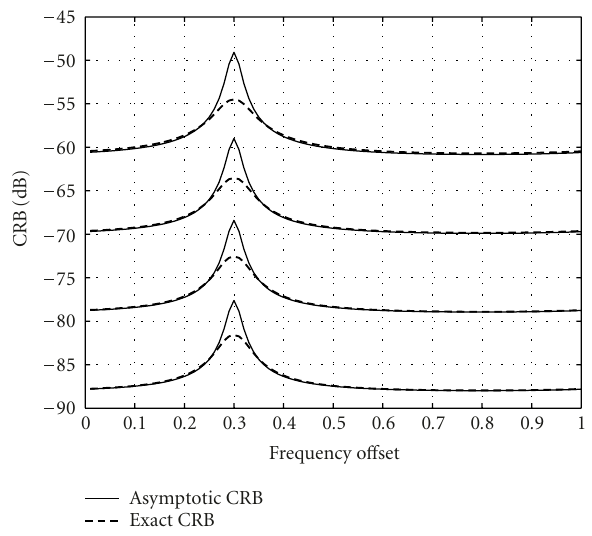
Figure 6: The asymptotic CRB and exact CRB in the presence of first-order AR colored noise and multiplicative noise for di ff erent values of N , N = 32,64,128,256. SNR = 10dB. Doppler frequency . 1. κ = f d = 0